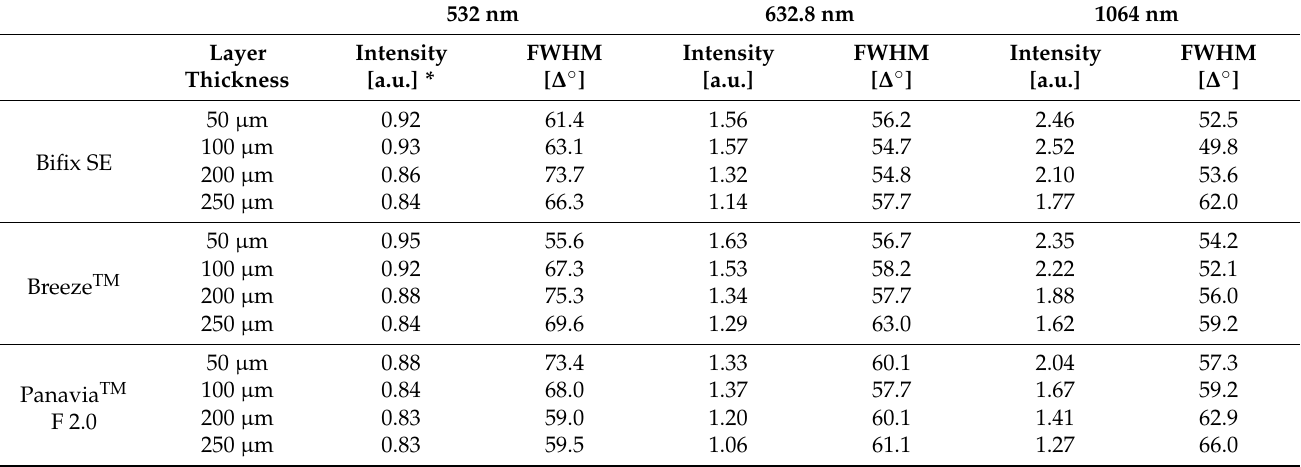
*: a.u. for arbitrary